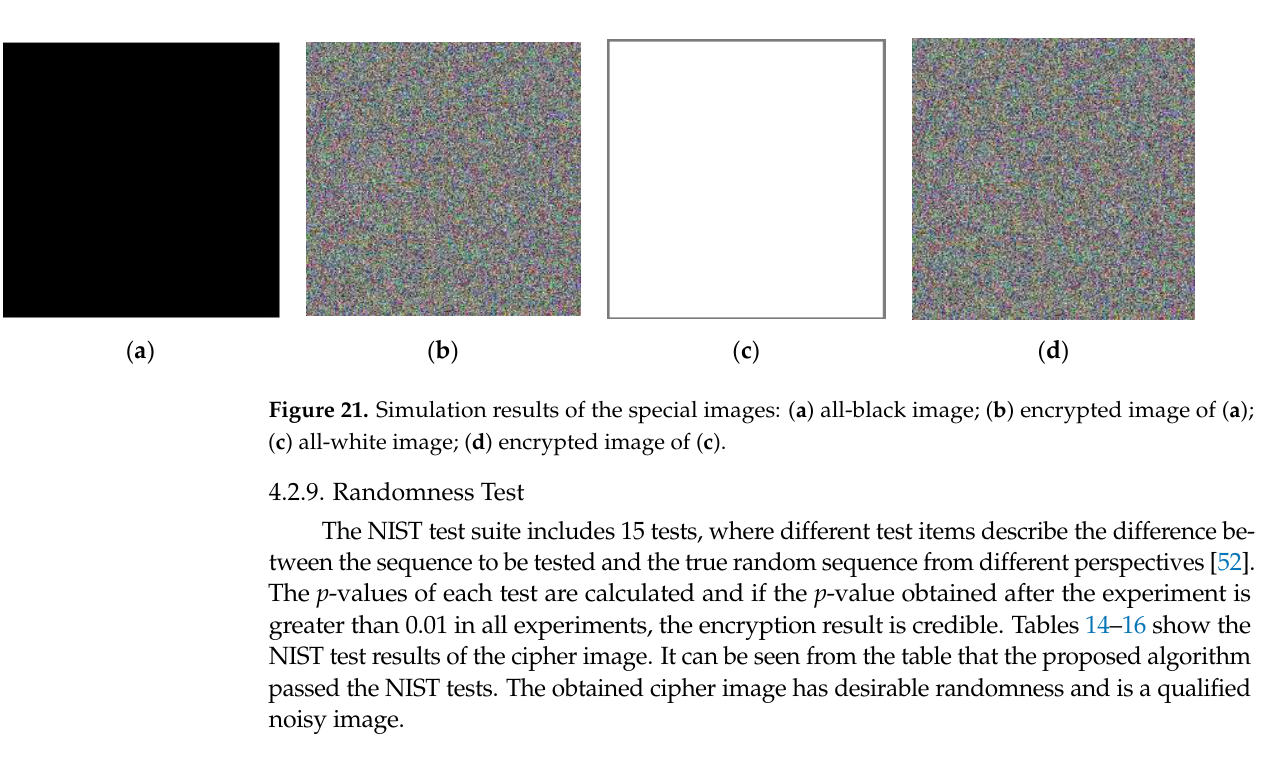
Table 14. NIST test results.